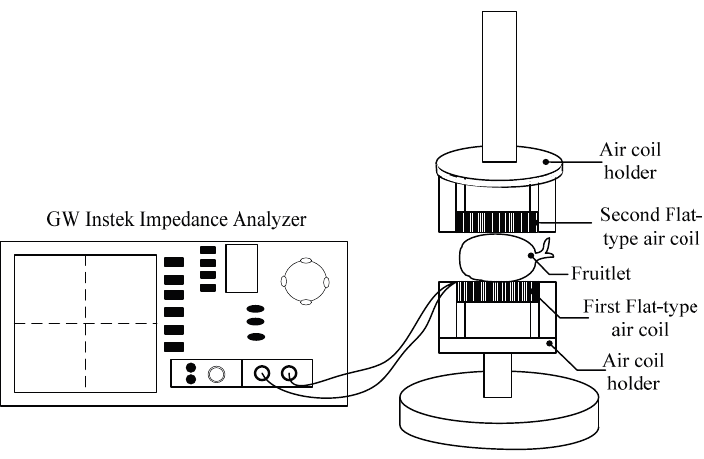
Figure 2. Experimental setup for the flat-type air coil.